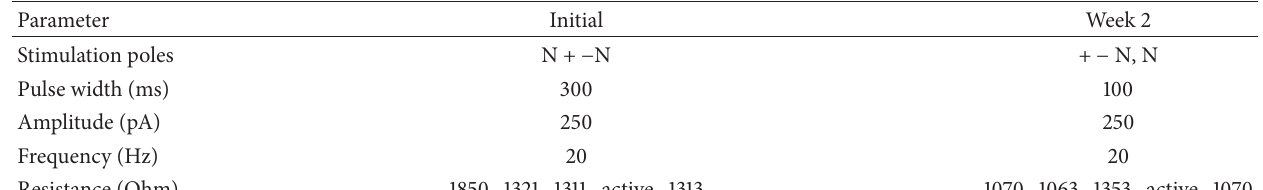
Table 1: Programming parameters.